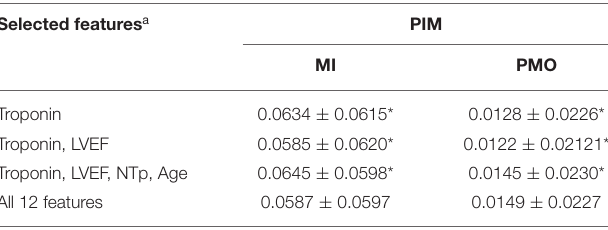
TABLE 6 | Percentage of Infarcted Myocardium prediction error with selected important features using Random Forest Regressor. Selected features a PIM MI